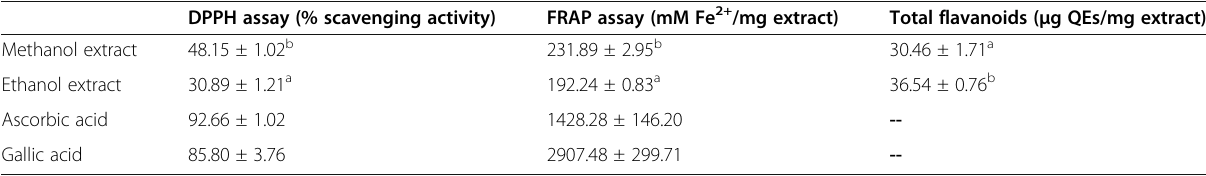
Table 2 Antioxidant potential and total flavonoids in methanol and ethanol extracts of E. crassipes leaf powder through DPPH